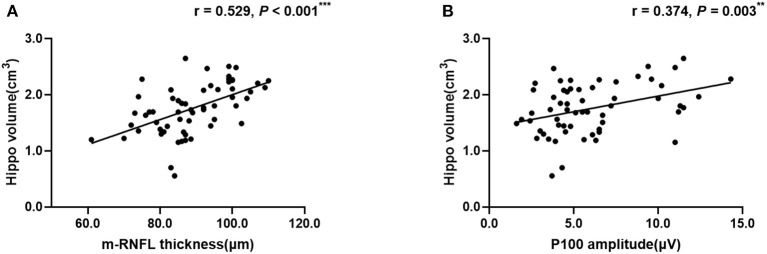
Correlation analysis between hippocampal volume and m-RNFL thickness (A) or P100 amplitude (B). The parameter was estimated using Pearson's correlation coefficients. Hippo, hippocampus; m-RNFL, macular retinal nerve fiber layer. ***P < 0.001, **P < 0.01.